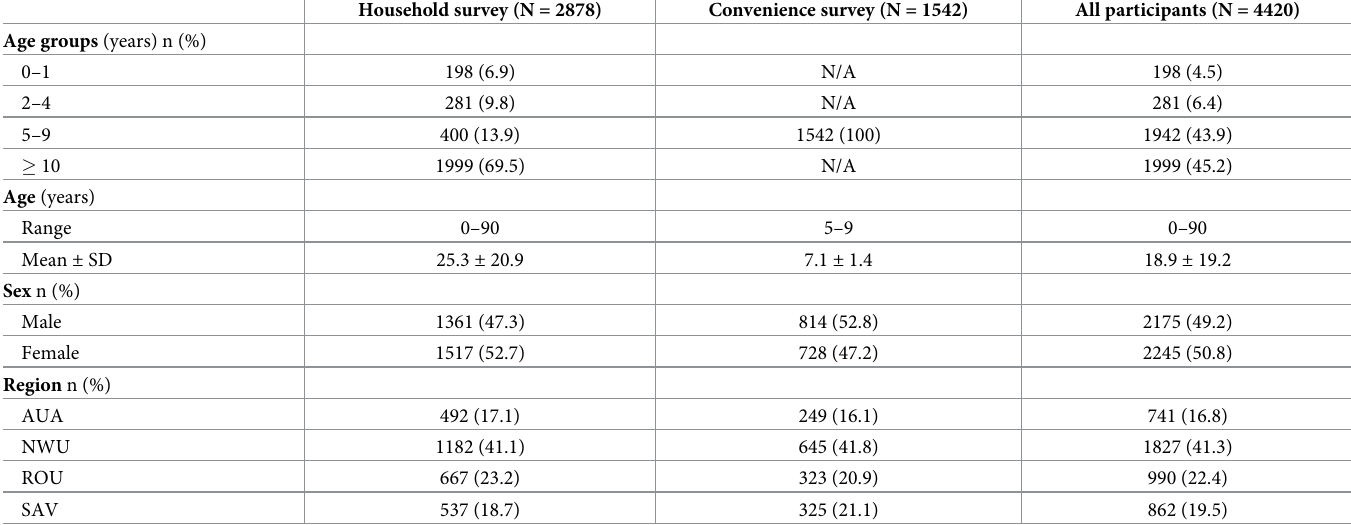
Table 1. Summary of study population demographic characteristics. Household survey (N =